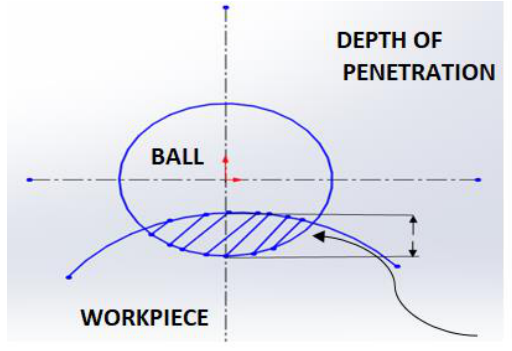
Figure 5. Depth of Figure 5. Depth of penetration.